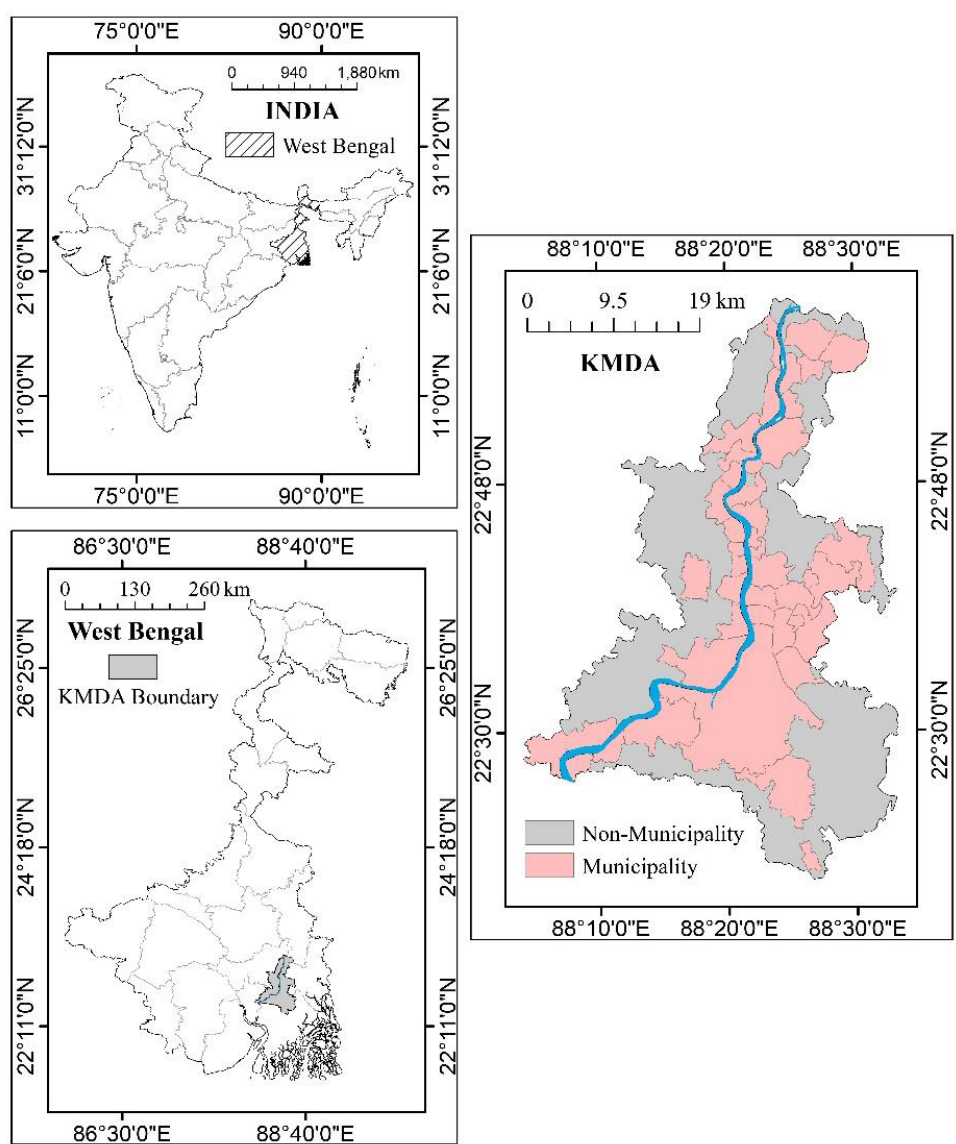
Figure 1. Location map of the study area .